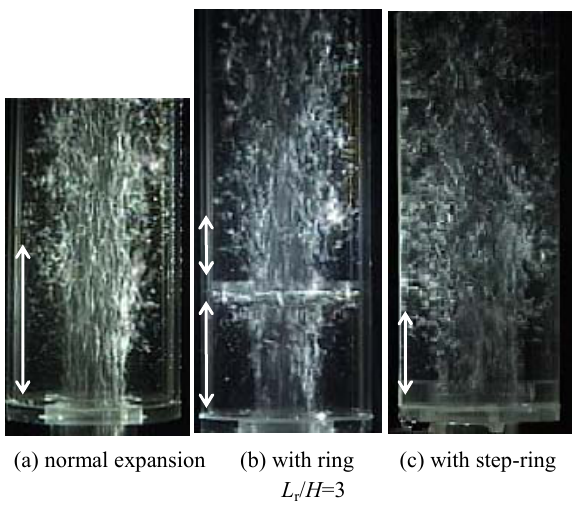
Fig.4 Visualized flow pattern after the